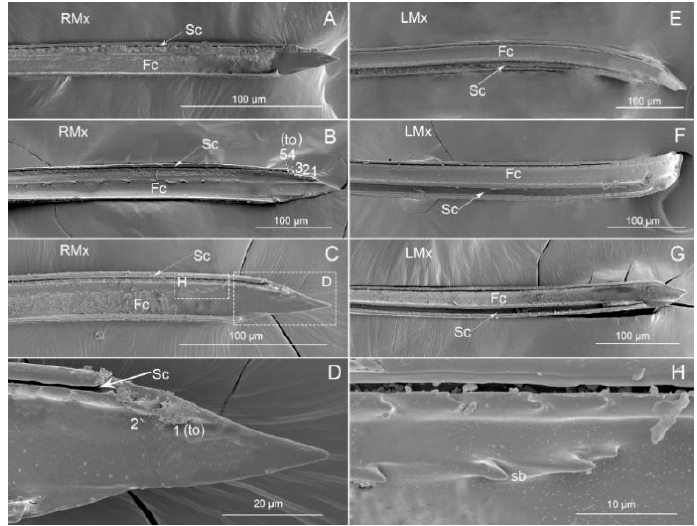
Figure 11. SEM images of maxillary stylets of three species. ( A ) Picromerus bidens ; ( B ) Picromerus lewisi ; ( C ) Cazira bhoutanica ; ( D ) Enlarged view of box in ( C ); ( E ) Picromerus bidens ; ( F ) Picromerus lewisi ; ( G ) Cazira bhoutanica ; ( H ) Enlarged view of box in ( C ); Fc, food canal; Sc, salivary canal; LMx, left maxillary stylet; RMx, right maxillary stylet; to, tooth; sb, short barbs; The number represents the number of teeth.